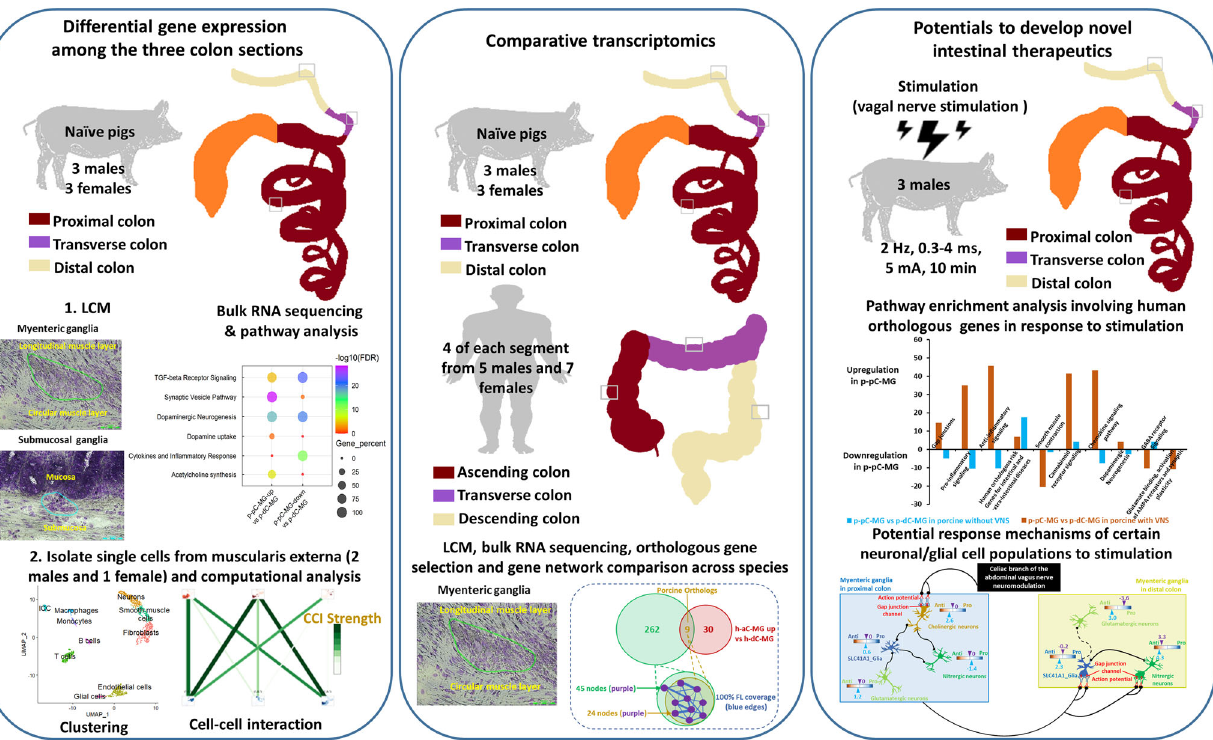
Fig. 1 Experimental design in the study. The transcriptomes were pro fi led in myenteric and inner submucosal ganglia (MG, ISG) from proximal, transverse and distal colon (p-pC, p-tC, p-dC) of six naive pigs, and MG in parallel from ascending, transverse and descending colon (h-aC, h-tC, h-dC, 4 of each) from 12 patients (5 males and 7 females) using laser-capture microdissection (LCM) coupled with bulk RNA-seq analysis. Gene homology search was performed to obtain the orthologous genes between human and pig. The high-quality orthologous differentially expressed genes (DEG) derived from comparisons of MG between analogous colonic regions across species were extracted and the coverage of their functional linkages in the gene networks was used to re fl ect functional similarities across species. Based on the orthologous genes, the discrepancy of the region-speci fi c gene programs was evaluated in MG and ISG after electrical stimulation of the celiac branch of the abdominal vagus nerve in the anesthetized pigs. Additionally, single-cell RNA-seq (scRNA-seq) was performed on the muscularis externa containing myenteric ganglia in three naive pigs (2 males and 1 female). Approximately, an average of 3200 cells (1400/3000/5300) from each p-pC individual, 3800 cells (2800/2200/6300) from each p-tC individual and 4100 cells (2400/5000/4920) from each p-dC individual were loaded on the 10× Genomics Chromium platform, generating 9 scRNA-seq datasets. This yielded an average of 1930 (735/2091/2965), 2318 (1993/1903/3057) and 2559 (1381/3918/2378) mapped single cells in each of p-pC, p-tC, and p-dC, respectively. The scRNA-seq was coupled with bulk gene expression deconvolution to identify cell-type marker genes and putative interactions among neurons and glia in MG of porcine colon and further revealed the regional transcriptomic heterogeneity in the enteric nervous system of the pigs with and without